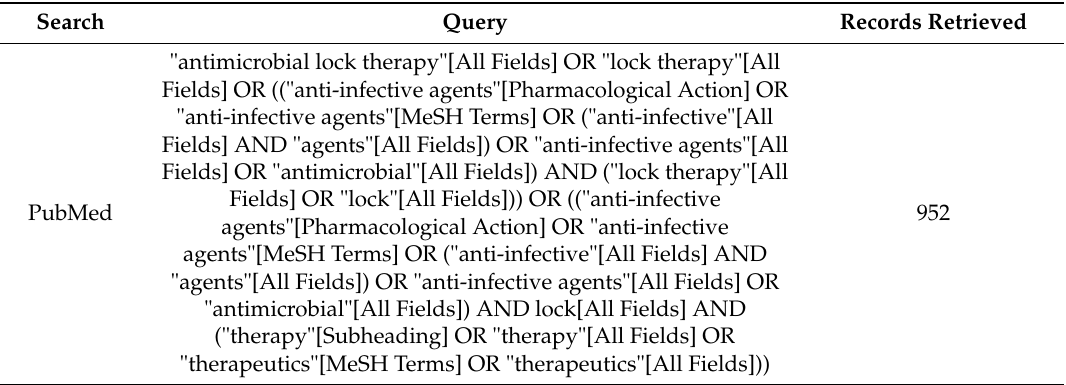
Table 1. Search strategy conducted on 7 February